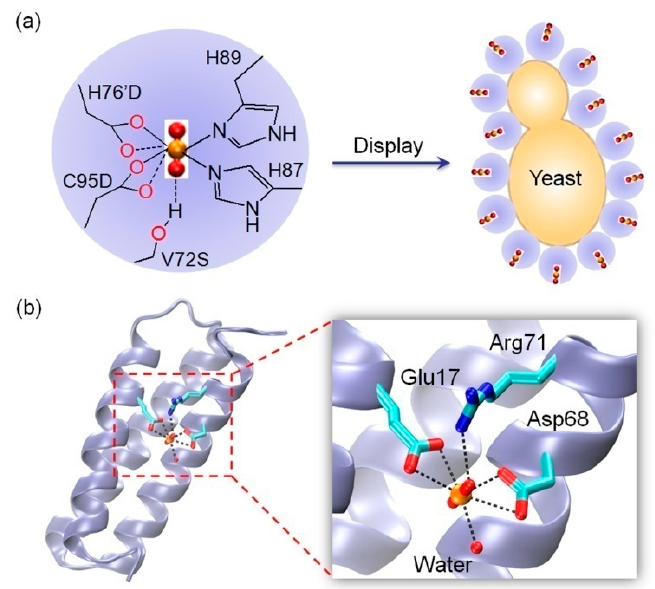
Figure 4. Rational design of an artificial uranyl binding site in native and de novo protein scaffolds. ( a ) Rational design of an artificial UO 22+ -binding site in NikR by V72S/H76’D/C95D mutations (left) [67], and display of the triple mutant on yeast surface (right) [68]; ( b ) An X-ray crystal structure of a de novo protein with an artificial UO 22+ -binding site, and a close-up view of uranyl-binding site, highlighting the coordination and H-bond interactions (PDB code 4FZP, chain B) [10].